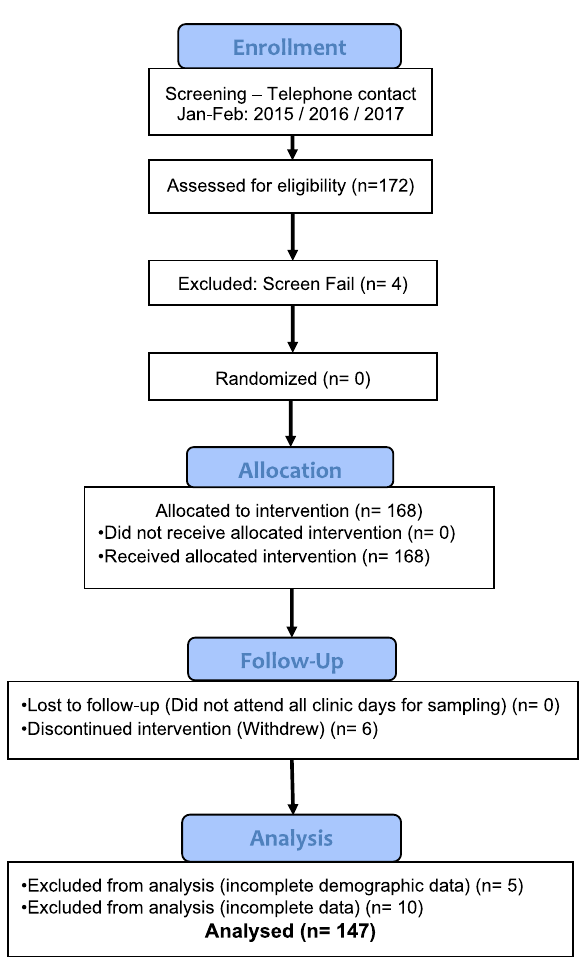
Fig. 3 Consort diagram for the study “ Using in fl uenza vaccination to understand and improve immune responses to vaccination in patients with COPD and healthy older people (IVC) ” . A fl ow diagram of the progress through the phases of a non-randomised, unblinded, observational